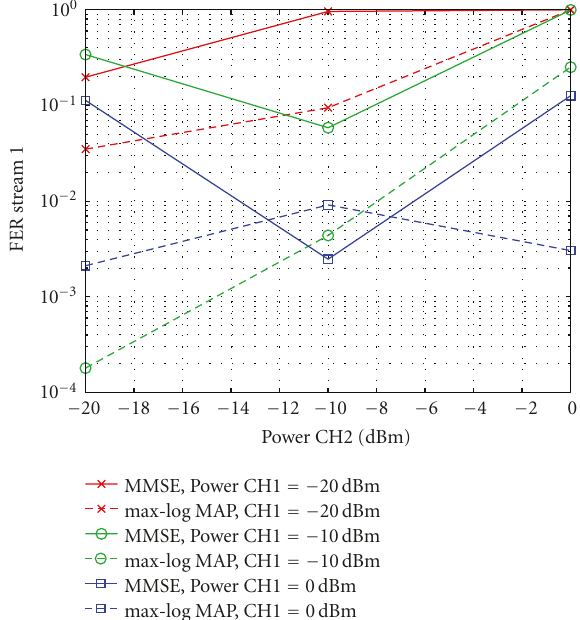
Figure 14: Measured frame error rate of the first stream using real- time MMSE and max-log MAP receiver in the Eurecom lab. Results are plotted for di ff erent power levels of the two